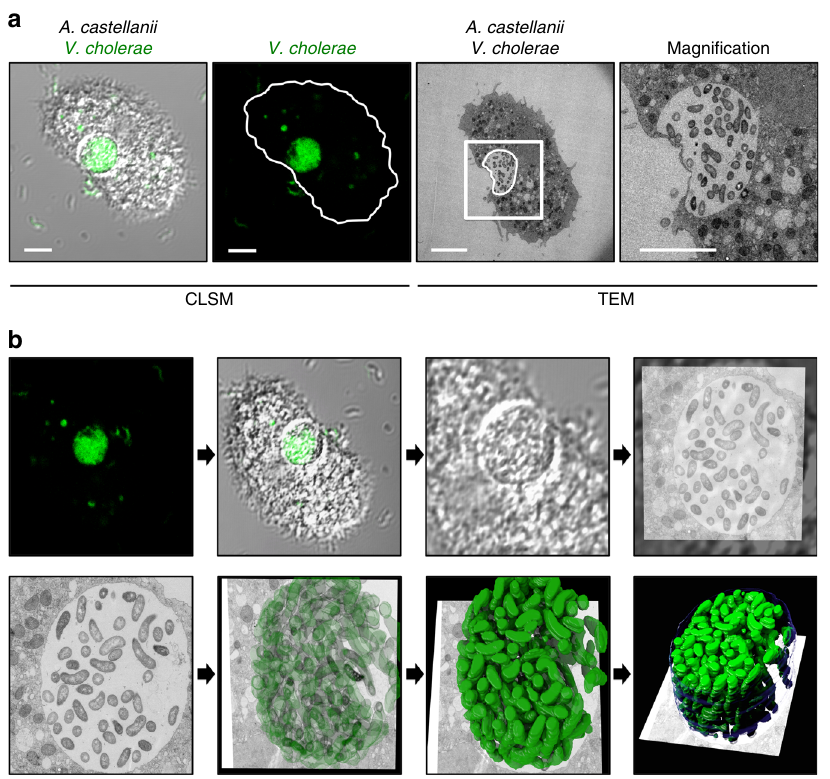
Fig. 1 Correlative light and electron microscopy (CLEM) for visualizing wild-type V. cholerae inside the contractile vacuole (CV). a Low- and high-resolution imaging of an infected amoeba. GFP-tagged V. cholerae were seen to be localized inside of a CV of A. castellanii using confocal laser scanning microscopy (CLSM; low resolution) in fi xed samples. Shown are a merged image of the transmitted light channel and the green channel (left) and the green channel image alone (second from left). After staining of the sample, the same amoeba was imaged at high resolution using transmission electron microscopy (TEM; right images). Scale bar in all images: 5 µ m. b 3D reconstruction of the colonized CV. The region containing the amoeba shown in a was serially thin sectioned (50 nm thickness) and serial images were taken with the TEM. These images were then aligned to generate a 3D model of the colonized amoeba. Shown are snapshots of the resulting 3D reconstruction movie (Supplementary Movie